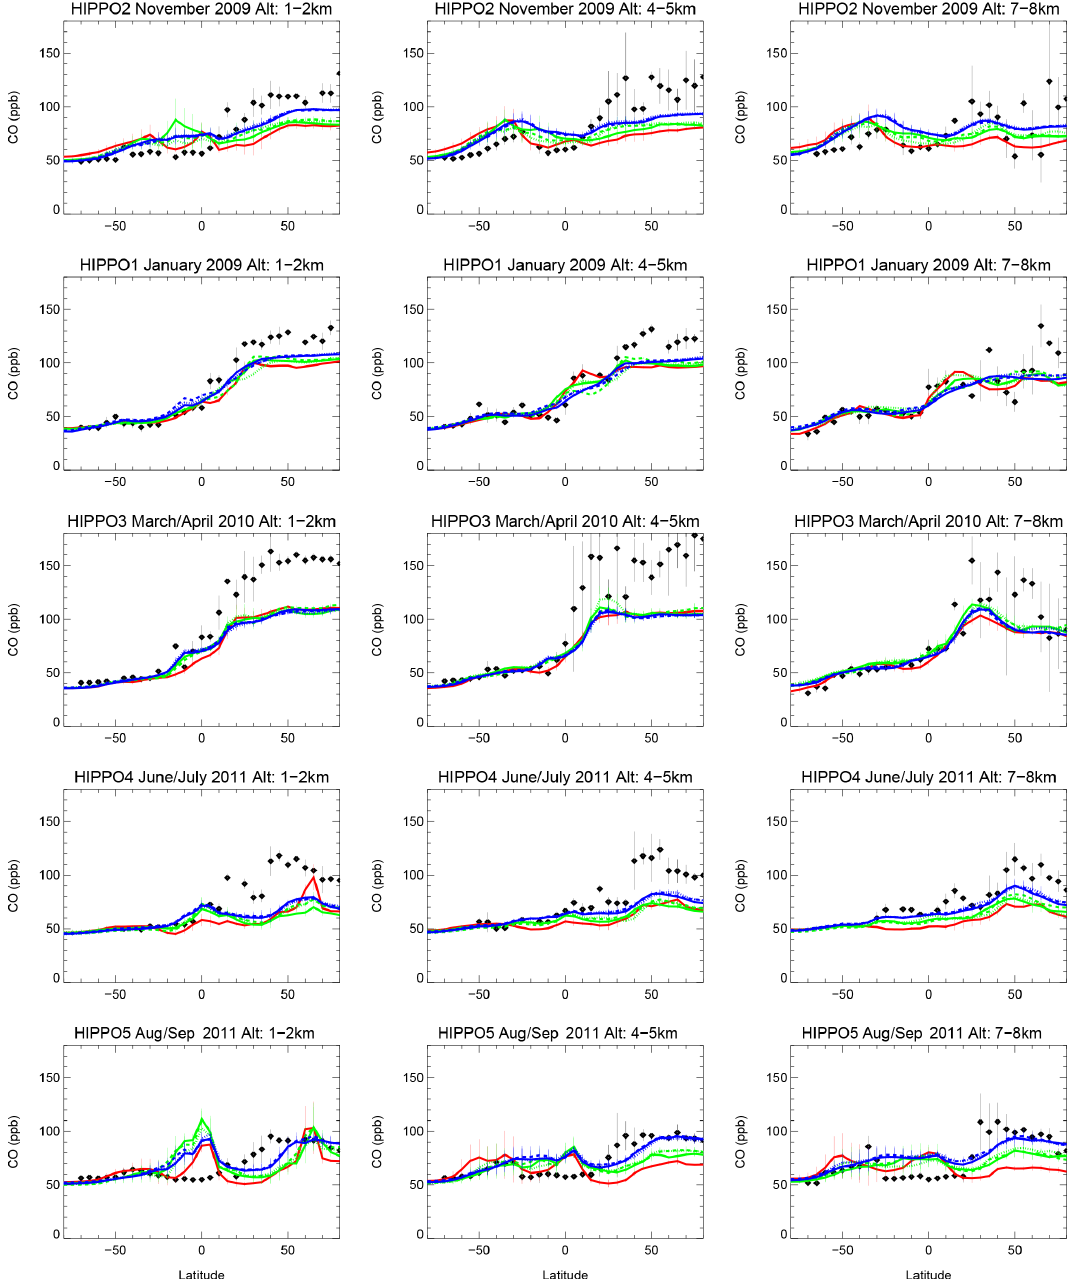
Figure A3. As Fig. A2, but for carbon